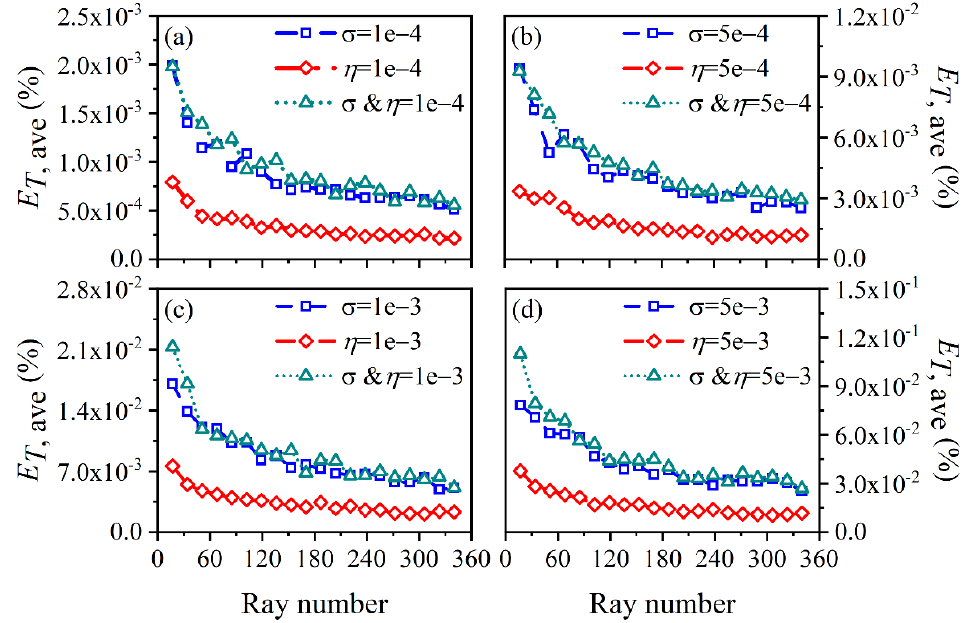
Figure 3. The average relative reconstruction error for temperature under different ray numbers considering the measurement error of the radiation intensity and coefficient matrix. ( a ) SNR = 80 dB; ( b ) SNR = 65 dB; ( c ) SNR = 60 dB; ( d ) SNR = 46 dB.